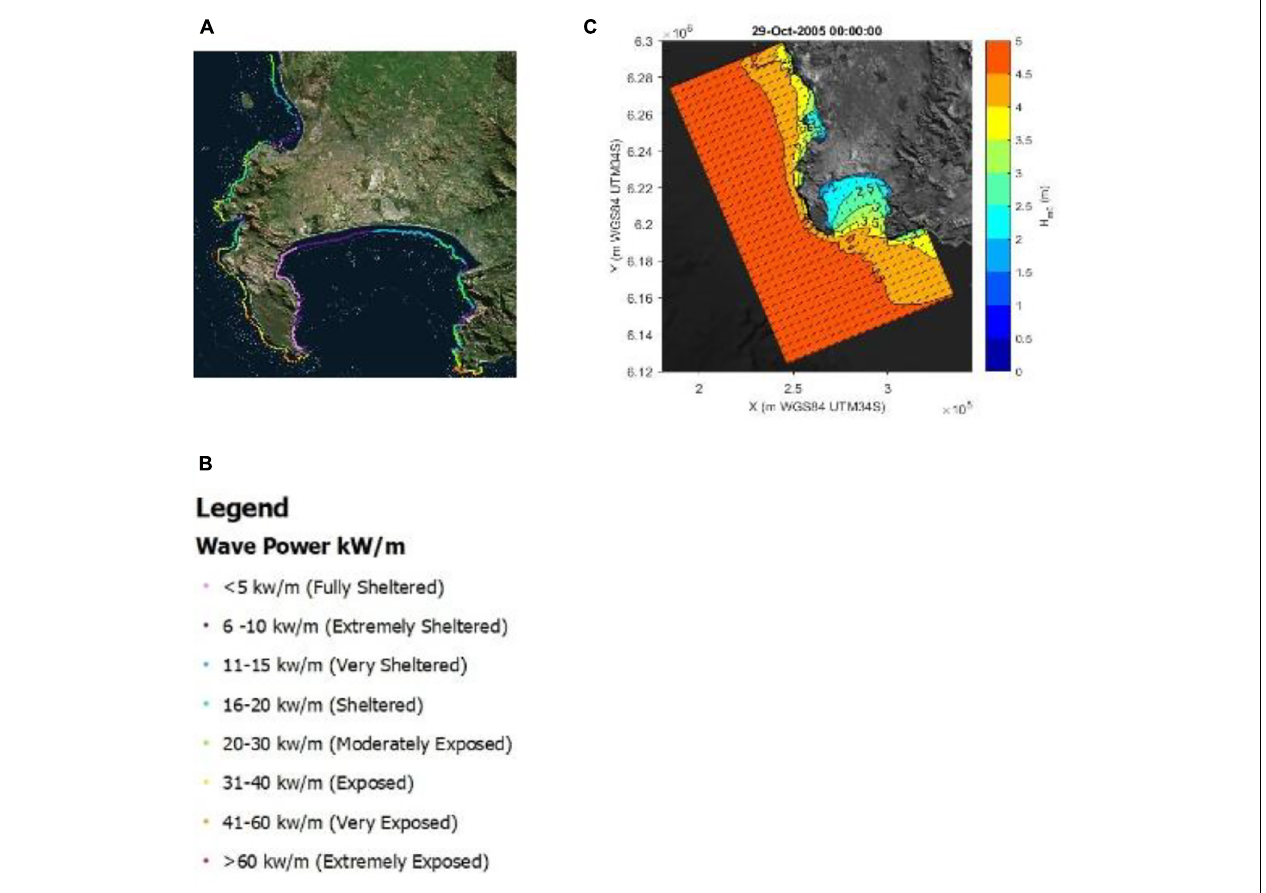
FIGURE 5 | The total coastal wave exposure of the Cape Peninsula is given in terms of wave energy (kW per meter wave crest length) is presented in panel (A) and the associated legend in panel (B) . The propagation of a typical offshore wave spectrum is given as produced from a single time-step in SWAN, is represented in panel (C)